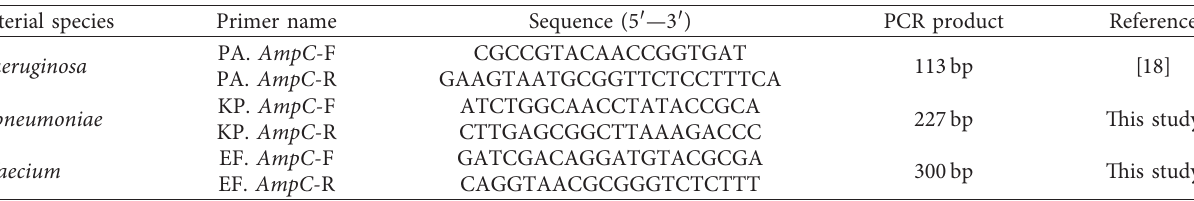
Table 1: PCR oligonucleotide primers used for the RT-qPCR amplification of the AmpC gene extracted from the bacterial species of our study.